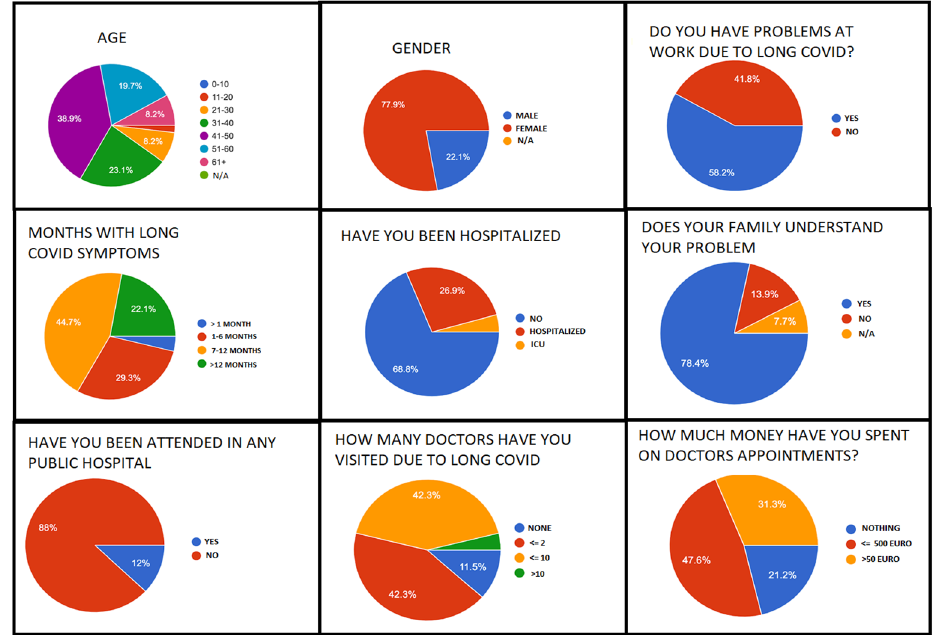
Figure 4. Socioeconomic impact of Long COVID. ICU: Intensive care unit, N/A: Non available.